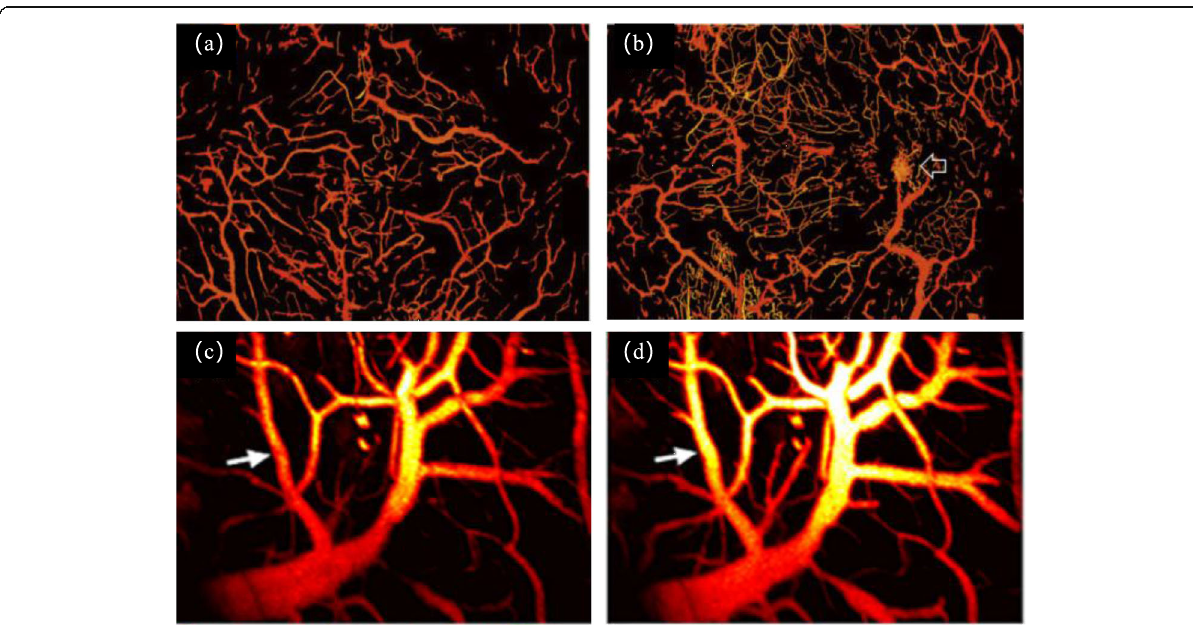
Fig. 3 In vivo imaging of cerebrovascular disease model using optical-resolution photoacoustic microscopy (OR-PAM). a , b PA images of normal and glioma mouse brains, respectively [55]. The tumor core is indicated by the arrow in b. c , d PA images of mouse brain under ischemia and perfusion, respectively [57]. The white arrows reveal an obvious change in diameter and intensity of a single vessel due to ischemia and